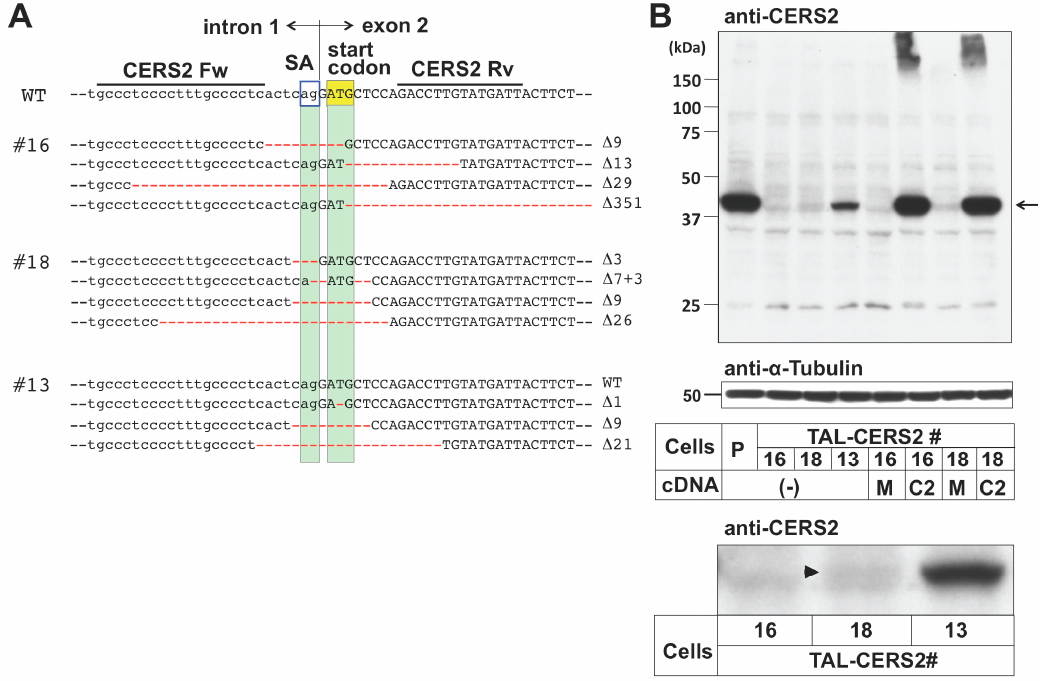
Figure 1. Isolation of CERS2 -deficient clones. ( A ) The target site of the TALEN-CERS2 pair in the human CERS2 gene and indel analysis in TALEN-CERS2–treated (TAL-CERS2) clones. The target sequences (CERS2 Fw and Rv) are located in intron 1 and exon 2, respectively. The sequence between the TALEN target sequences contains the start codon (yellow box) and the splicing acceptor (SA) at the end of intron 1 (blue lined box). Green boxes highlight the portions corresponding to the start codon and the SA. Deletions are shown in red and their lengths are specified on the right of the sequences; ( B ) Western blot analysis of CERS2 in the TAL-CERS2 clones. Cell lysates from the parent cells and CERS2-deficient mutants were immunoblotted with anti-CERS2 antibody ( top ) and anti- α -tubulin antibody ( middle ). Part of the enlarged view of the top image is shown at the bottom . The arrow and arrowhead indicate CERS2; P, parent cell line; 16, TAL-CERS2#16 clone; 18, TAL-CERS2#18 clone; 13, TAL-CERS2#13 clone; (-), no transfection; M, mock; and C2, CERS2 cDNA